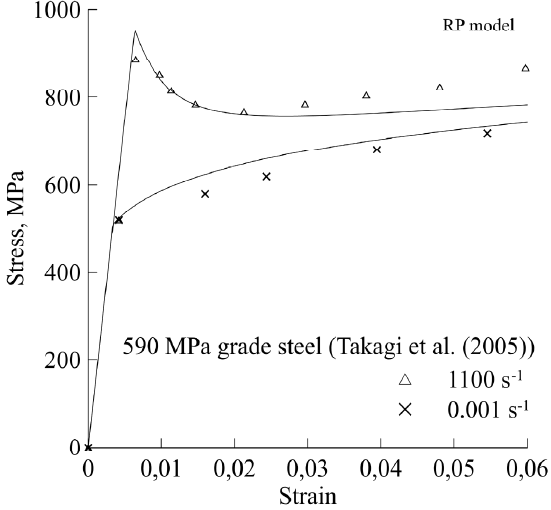
Fig. 6. Stress-strain dependences of 590 MPa grade steel (data from [2]) on strain rates 0.001 s –1 and 1100 s –1 , predicted by relaxation model of plasticity ( E =210 GPa,  =280 MPa;  =2.5,  =8.5  s, y 